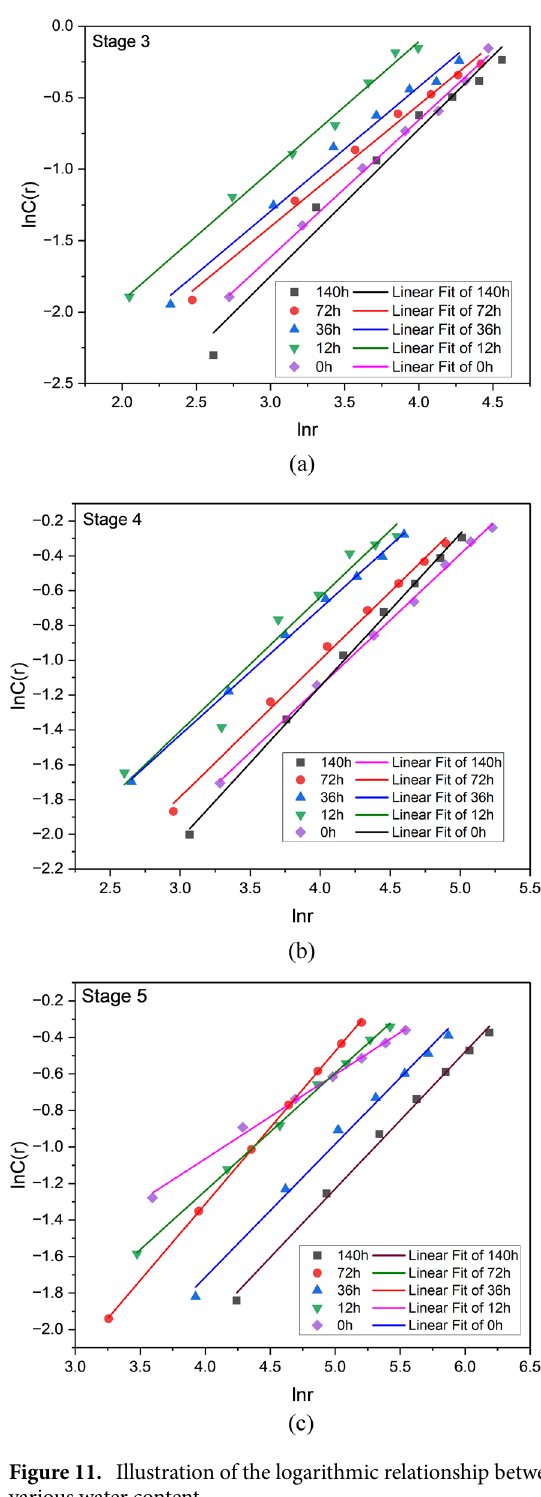
Figure 11. Illustration of the logarithmic relationship between acoustic emission energy and coal sample with various water